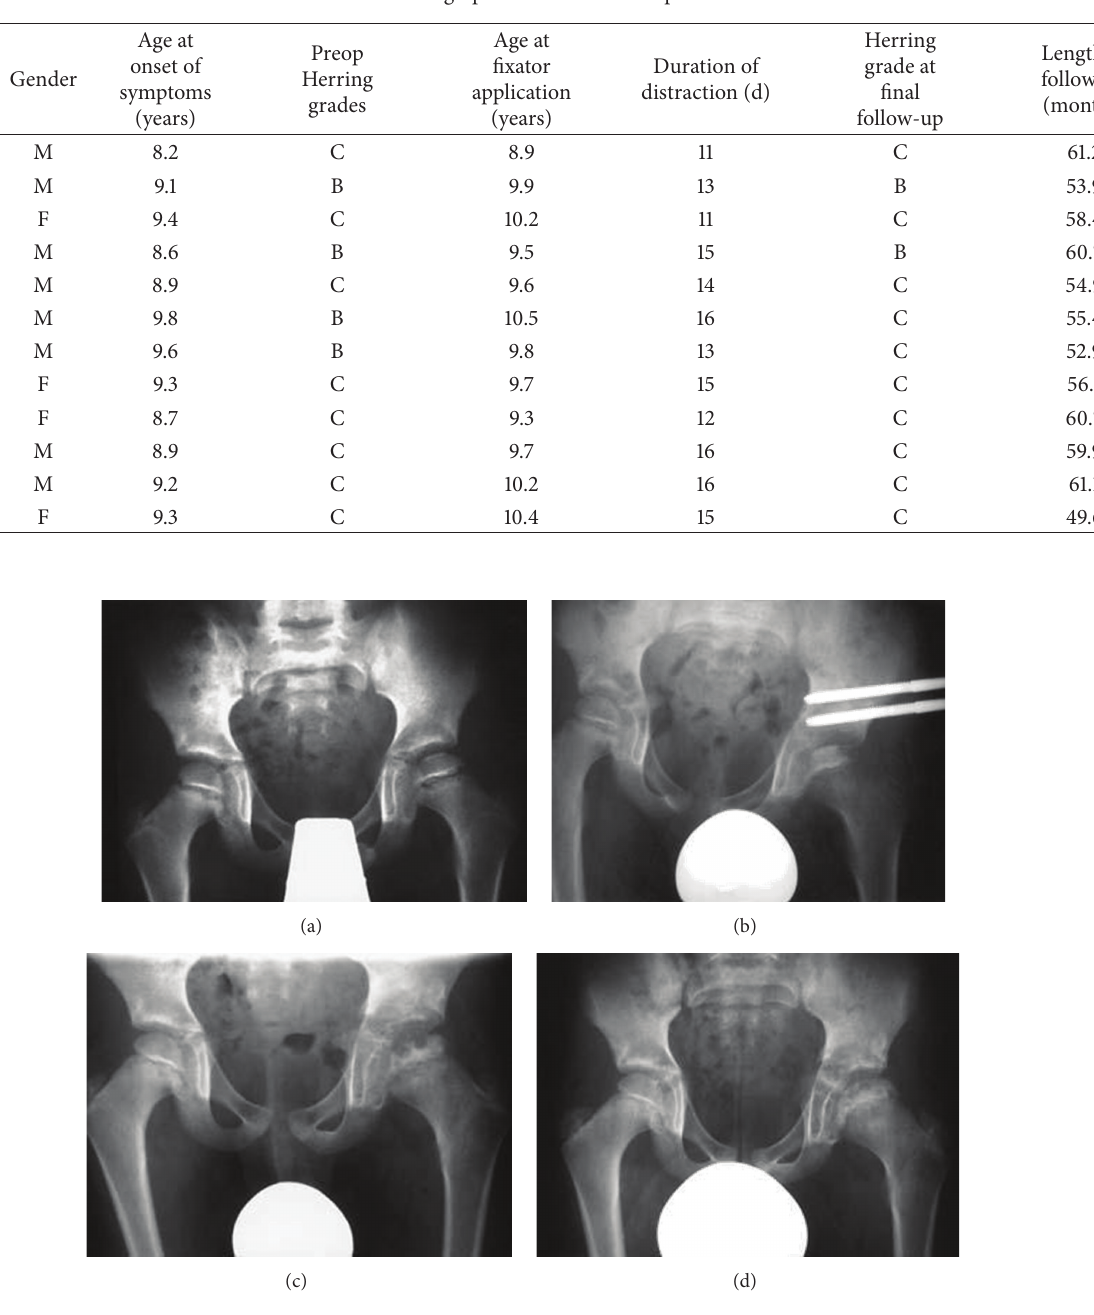
Figure 1: A 10.2-year-old female patient with Perthes’ disease for the last eight months. (a) Managed with hinged monolateral external fixator, showing increased sclerosis of epiphysis with maintaining the epiphyseal height (b). At 1-year follow-up further collapse of epiphysis with osteolysis (c) was evident, which was resolved by last follow-up at 33.4 months with improved epiphyseal index